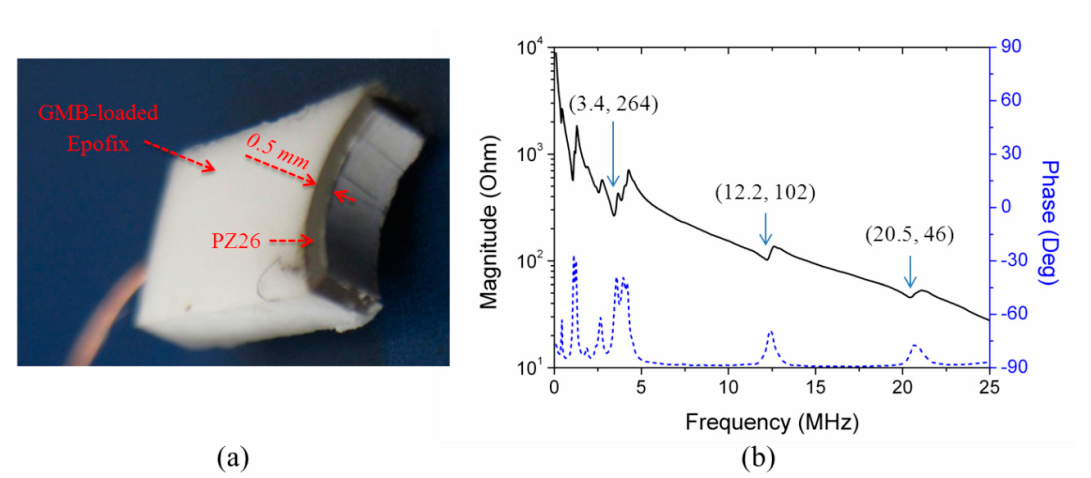
Figure 15. ( a ) A fabricated PZ26 quarter-ring focused transducer with GMB-loaded Epofix backing; and ( b ) its impedance spectrum in